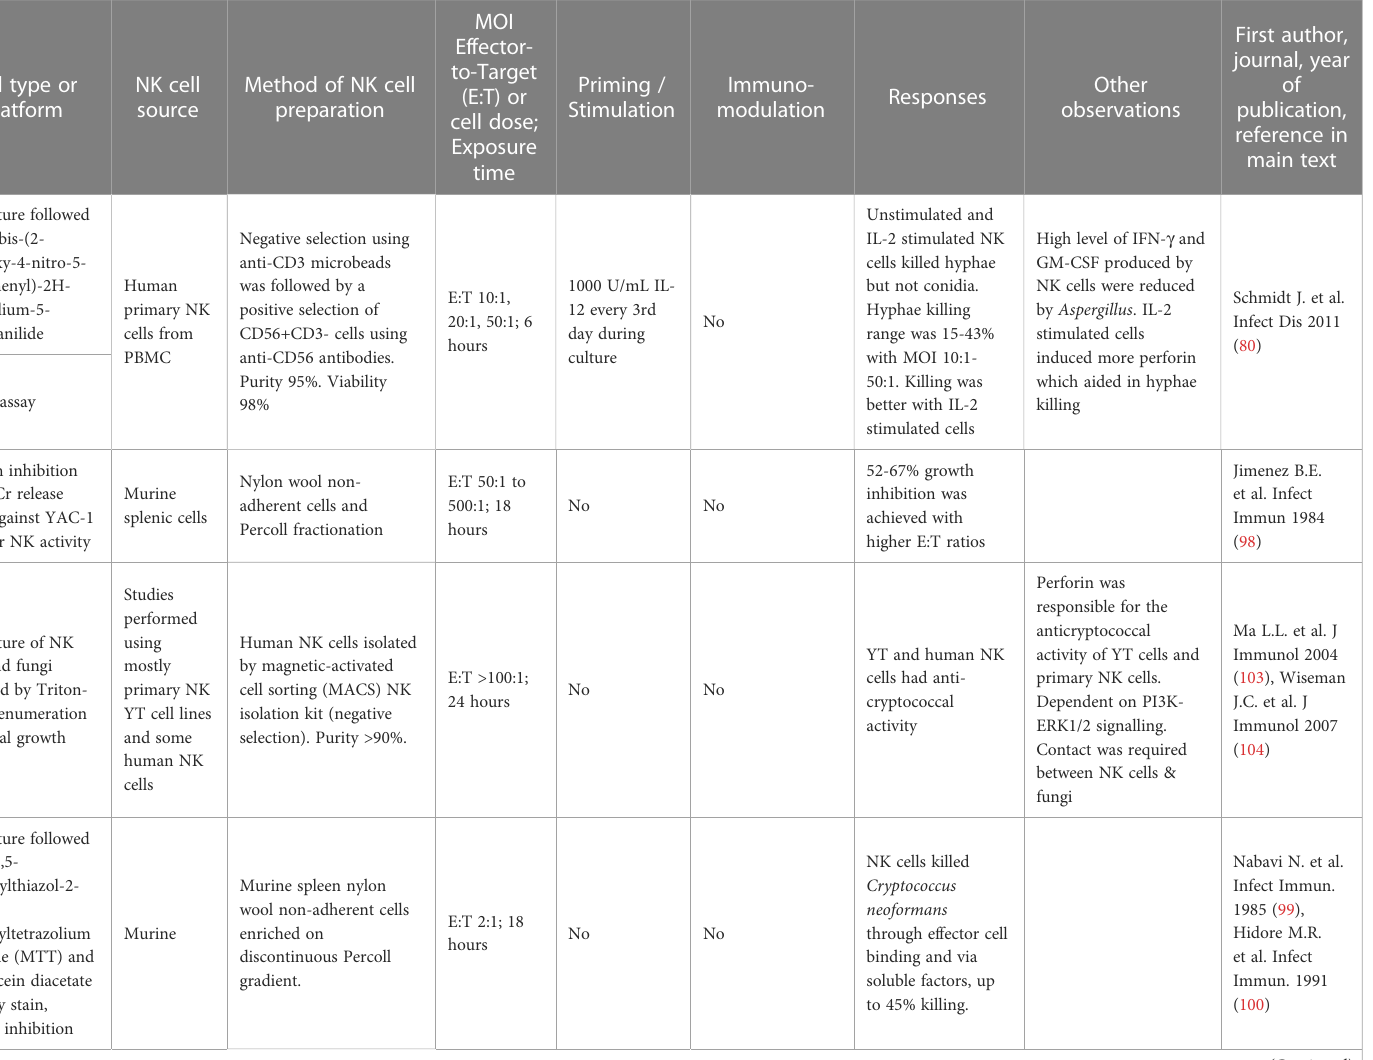
TABLE 1 Progressive development of fungal-speci fi c NK cellular